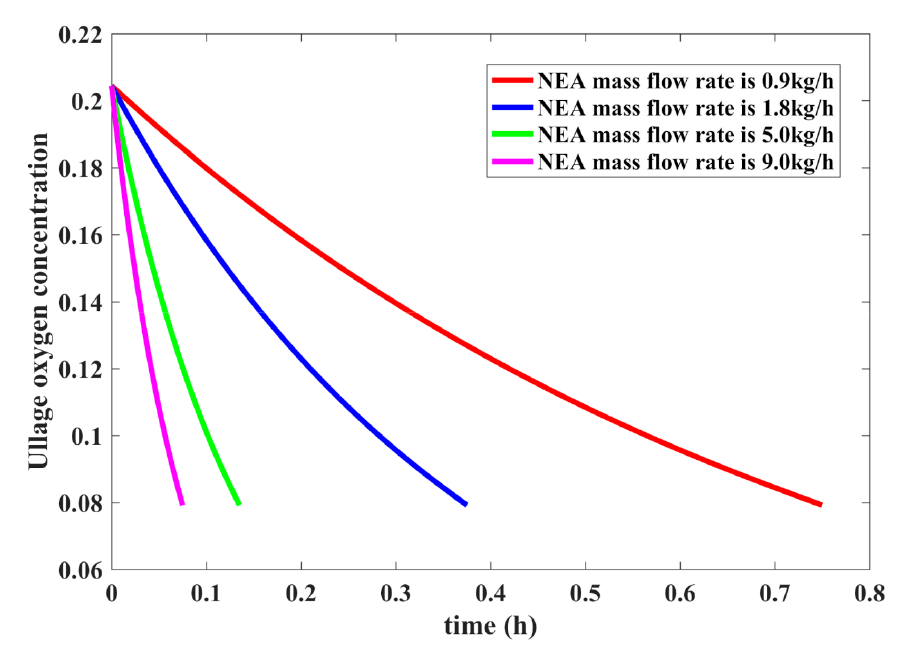
Figure 4. The ullage oxygen concentration z Uov regarding the NEA mass flow rate while keeping other pre-takeoff experimental variables unchanged.